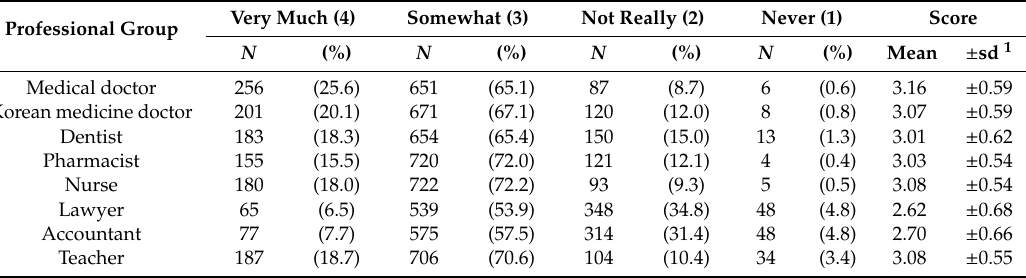
Table 3. Trust level of various professional